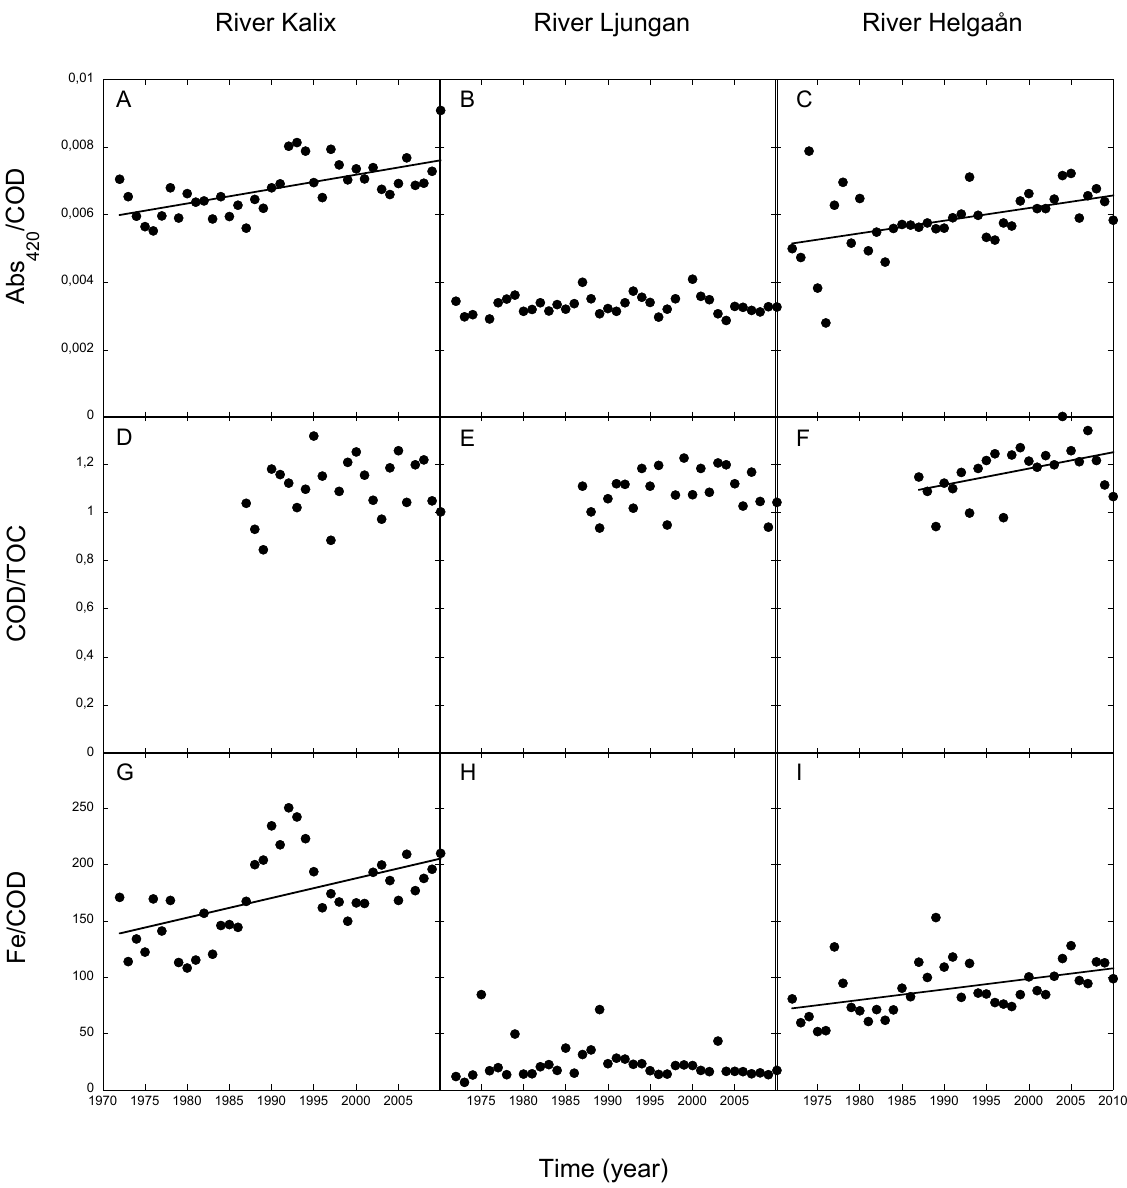
Fig. 6. Trends in Abs 420 /COD, COD/TOC and Fe/COD in rivers in northern (Kalix˚an), central (Ljungan) and southern Sweden (Helga˚an). Trend lines are shown when there are significant increases over